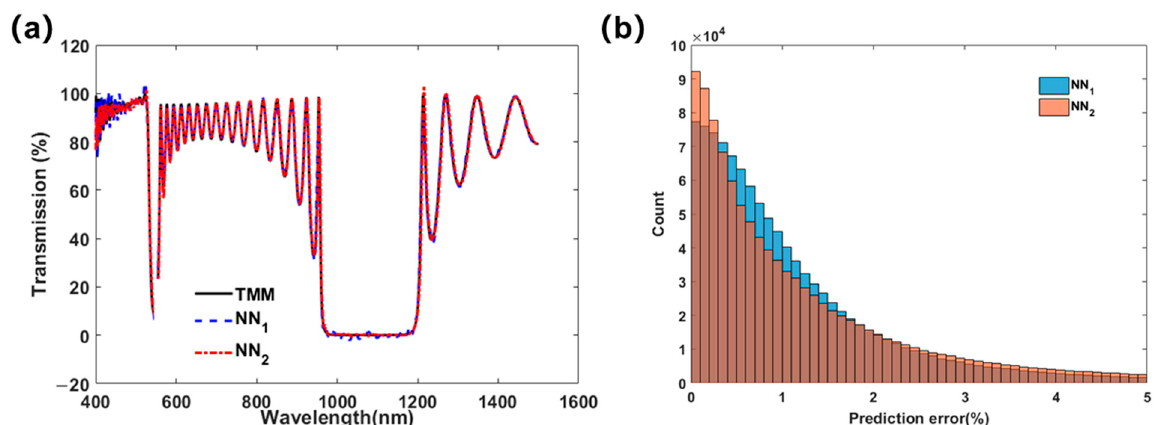
Figure 10. ( a ) The predicted spectra compared to the original one that was randomly selected from the training dataset and ( b ) the error distributions for the two NNs. Then, the trained NN can be used in PSO to find the layer thicknesses corresponding to the experimental spectrum. Here, the PSO searching ranges for the layer thicknesses were the same as the forward NN. For NN1, the number of particles was 20, the maximum number of iterations was 50, and the experimental curve accumulated 25 inverse designs, whose distribution is shown in Figure 11a. It can be seen that the predicted thicknesses were generally around 178.20 nm for SiO 2 and 127.73 nm for Ta 2 O 5 , which were the mean values of the samples close to the growth values of 179.57 nm (SiO 2 ) and 126.43 nm (Ta 2 O 5 ), i.e., with REs of 0.77% (SiO 2 ) and 1.03% (Ta 2 O 5 ) for NN1-PSO. For NN2, the number of PSO particles was 60, the maximum number of iterations was 50, the repeated time of inverse designs was 25, and the distribution of the results is shown in Figure 11b. It can be seen that the results of D3 and D4 were close to 178.66 and 127.14 nm (with REs of 0.51% and 0.56%), while the other four parameters had large fluctuations. This may be because D3 and D4 represent the majority of the thickness of the Bragg layers except for the top and bottom ones. Thus, these two parameters affect the spectrum more than the others. Moreover, this indicates that the Bragg structure is relatively robust against variations in the individual layers, such that even if the top and bottom layers fluctuate heavily, the spectrum still keeps its main